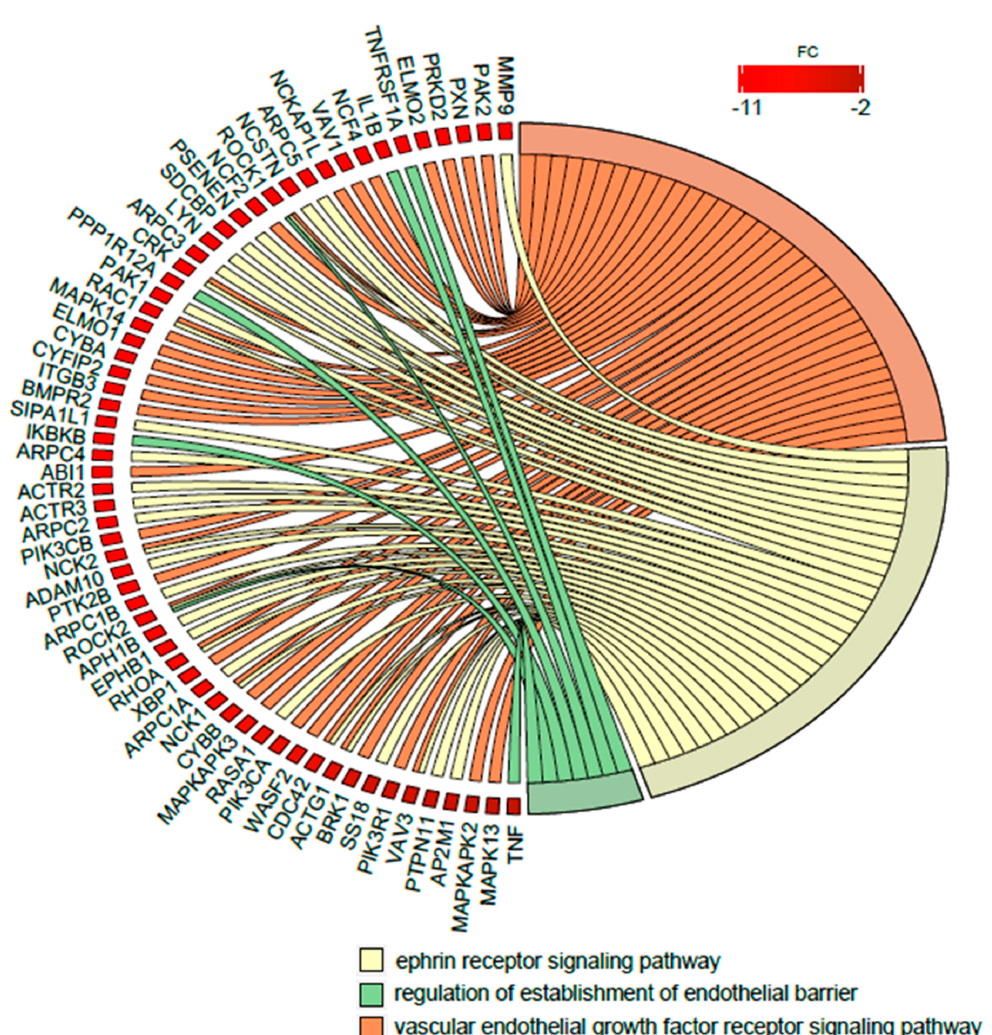
Figure 5. Detailed analysis of three enriched gene ontological groups involved in angiogenesis regulation in preterm newborns. Circos plots with interdependence between selected GO terms and their genes. Symbols of differentially expressed genes (DEGs) are presented on the left side of the graph with their fold change values, mapped by color scale (red = lower expression). Moreover, the color intensity of the rectangle next to the marked gene name reflects the order of magnitude of the change in gene expression. Gene involvement in the GO terms was determined by colored connecting lines.